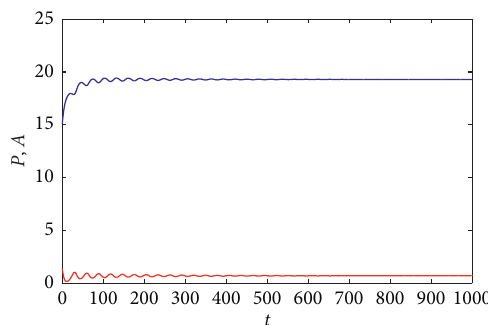
Figure 2: Graph of S ( τ ) versus τ for system (4). j